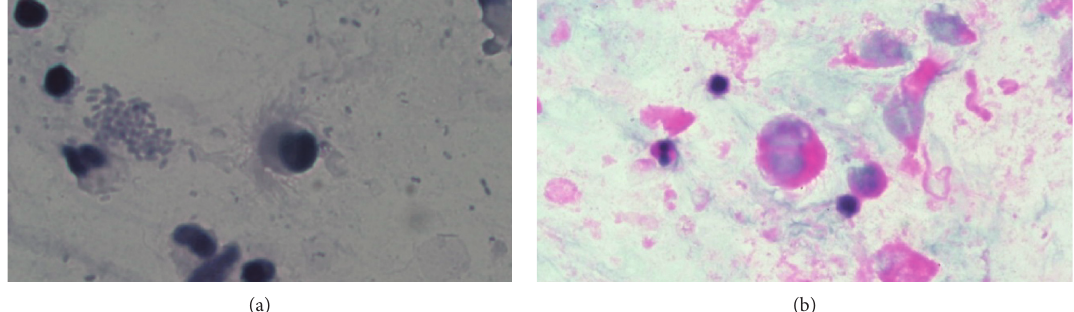
Figure 1: Trophozoite of L. blattarum with long flagella in a sputum sample: (a) H&E and (b) Papanicolaou stain.